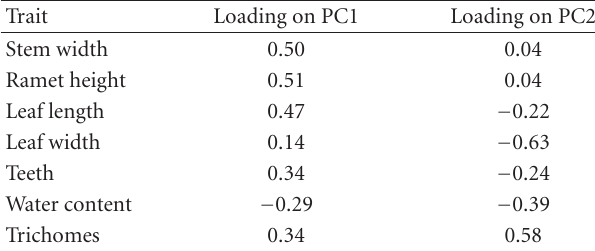
Table 3: Factor loadings for the first two principal components from the morphological data matrix for S. altissima and S. gigantea